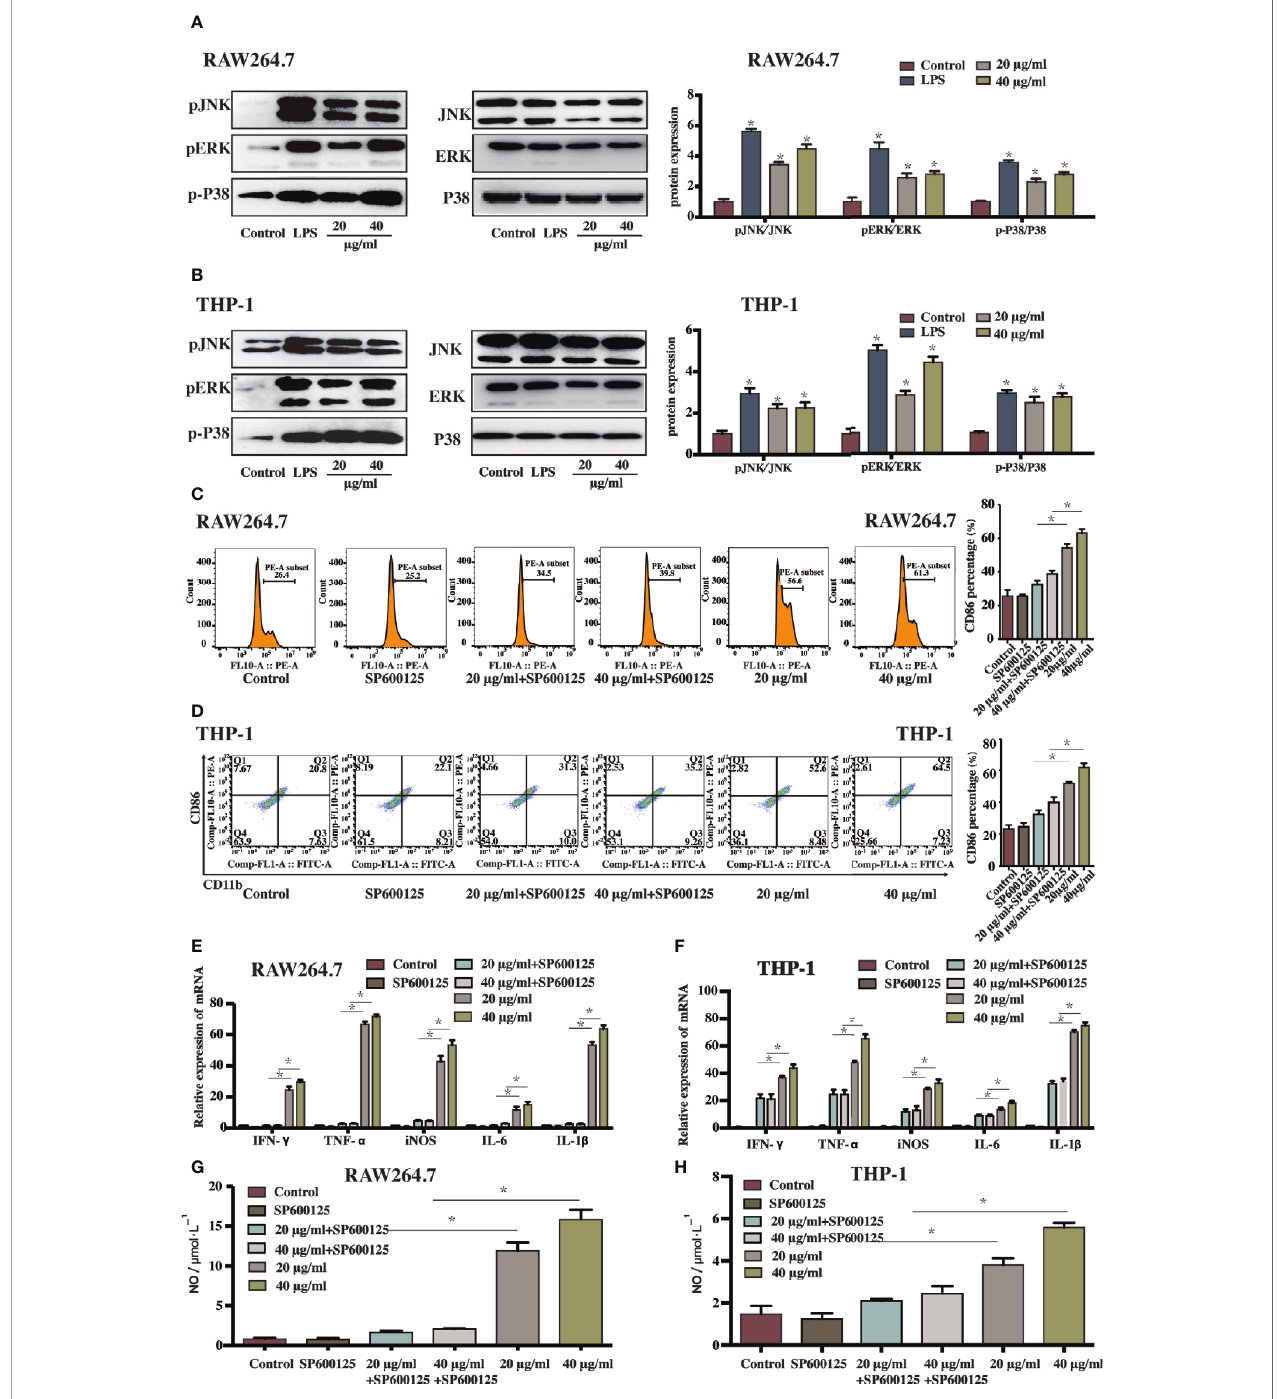
FIGURE 3 | The sophoridine induced macrophages differentiation and produced pro-in fl ammatory cytokines via the MAPKs signaling pathway (A, B) The relative protein expression of p-JNK, p-ERK, and p-P38 (relative to JNK, ERK, and P38, respectively) in RAW264.7 and THP-1-derived macrophages determine by Western Blotting. (C, D) The percentage of CD86 of sophoridine-stimulated RAW264.7 and THP-1-derived macrophages with or without SP600125 treatment. (E, F) The relative expression of IFN- g , TNF- a , IL-6, iNOS, and IL-1 b mRNA in sophoridine-stimulated RAW264.7 and THP-1-derived macrophages with or without SP600125 treatment determine by RT-PCR. (G, H) The NO production of sophoridine-stimulated RAW264.7 and THP-1-derived macrophages with or without SP600125 treatment (n = 3), p < 0.05